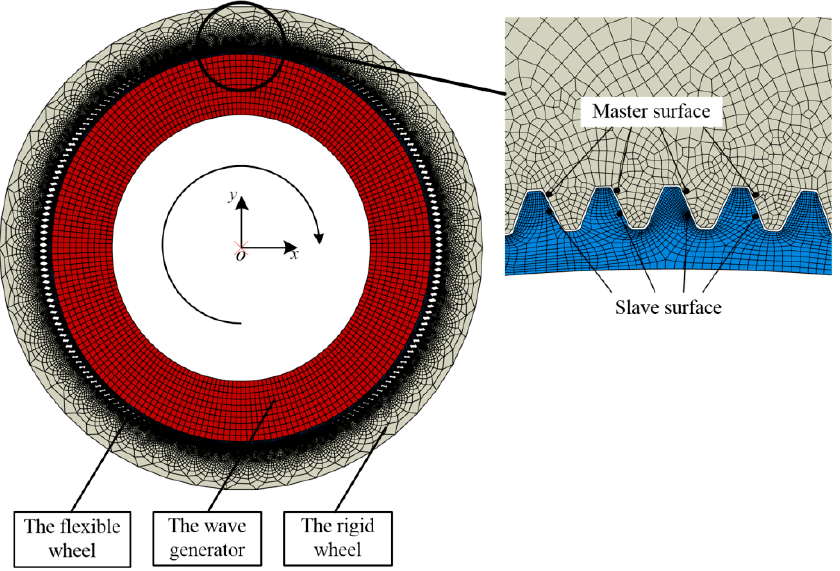
Figure 16. Finite element assembly model and the partial enlargement of the meshing area of the disposable HD.